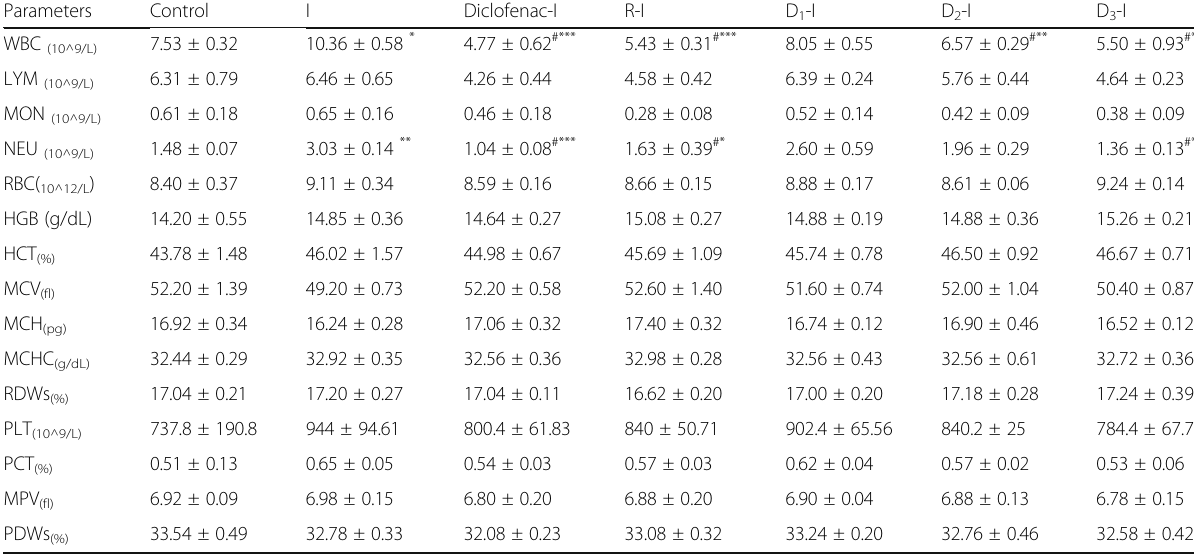
[ WBC White blood cell count, NEU the Number of neutrophils, MON Monocytes, LYM Lymphocytes, RBC Red blood cells count, HGB Haemoglobin concentration, HCT Haematocrit, MCH Mean corpuscular haemoglobin, MCV Mean corpuscular volume, MCHC Mean corpuscular haemoglobin concentration, RDW Red blood cell distribution width, PLT Platelet count, PCT Thrombocytocrit, MPV Medium platelet volume and PDW Platelet distribution width] * Significant at p <0.05; ** Significant at p <0.01; *** Significant at p <0.001 – compared with C group; # Significant at p <0.05; ## Significant at p <0.01; Significant at p <0.001 – compared with I